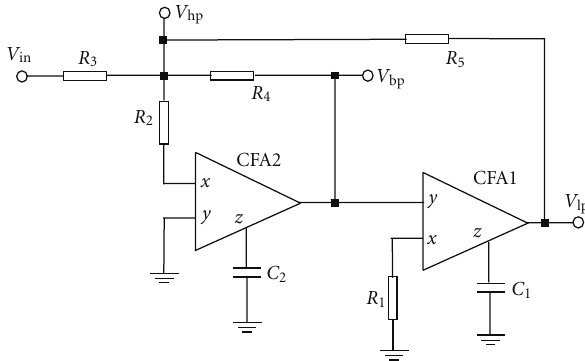
Figure 1: The proposed voltage-mode lowpass, bandpass and highpass